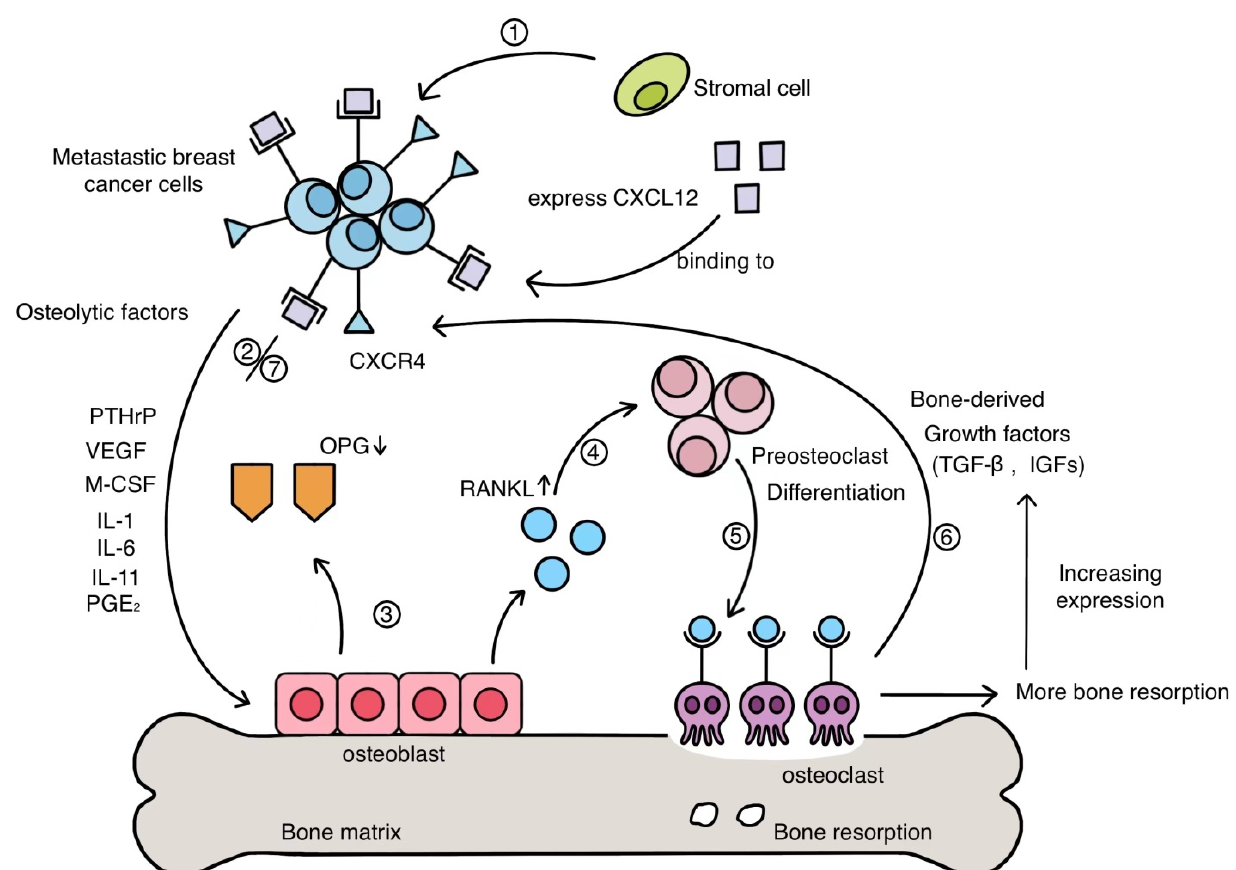
Figure 1. An overview of the “vicious cycle of bone metastasis” (the figure is reproduced from reference [44] with modifications to the original source). A vicious cycle happens when tumour cells secrete osteoclast-stimulating factors, while bone marrow stromal cells secrete tumour growth factors. TGF- β is a pleiotropically expressed multifunctional cytokine that controls tissue homeostasis by regulating cellular apoptosis, proliferation, and differentiation [45]. In metastasis progression, the TGF- β signal can suppress E-cadherin expression by activating the TGF- β receptors and phosphorylating the receptor-activated SMAD2 and SMAD3 [46]. In addition, TGF- β can upregulate the expression of pre-osteolytic factors such as PTHrP [47]. It has been proven that BC cells in metastatic bone sites express larger quantities of PTHrP compared to the cells in the primary breast site [48]. These factors enhance BC cell proliferation and remodelling the bone microenvironment by inducing angiogenesis and osteoclastogenesis, making the bone microenvironment more suitable for BC cells to colonise. TGF- β , IGFs, BMPs as well as the high level of calcium can simultaneously stimulate the overexpression of PTHrP and those growth factors mentioned above, leading to osteoclastic bone destruction. Subsequently, the resorbed bone further promotes the expression of TGF- β and IGFs. The release of these factors increases the amount of PTHrP produced by BC cells. As a result, more bone resorption is caused, which eventually promotes a vicious cycle of bone metastasis [49]. With the help of the appropriate bone microenvironment, BC cells can proliferate in the bone. An overview of invasion and metastasis is illustrated in Figure 2.